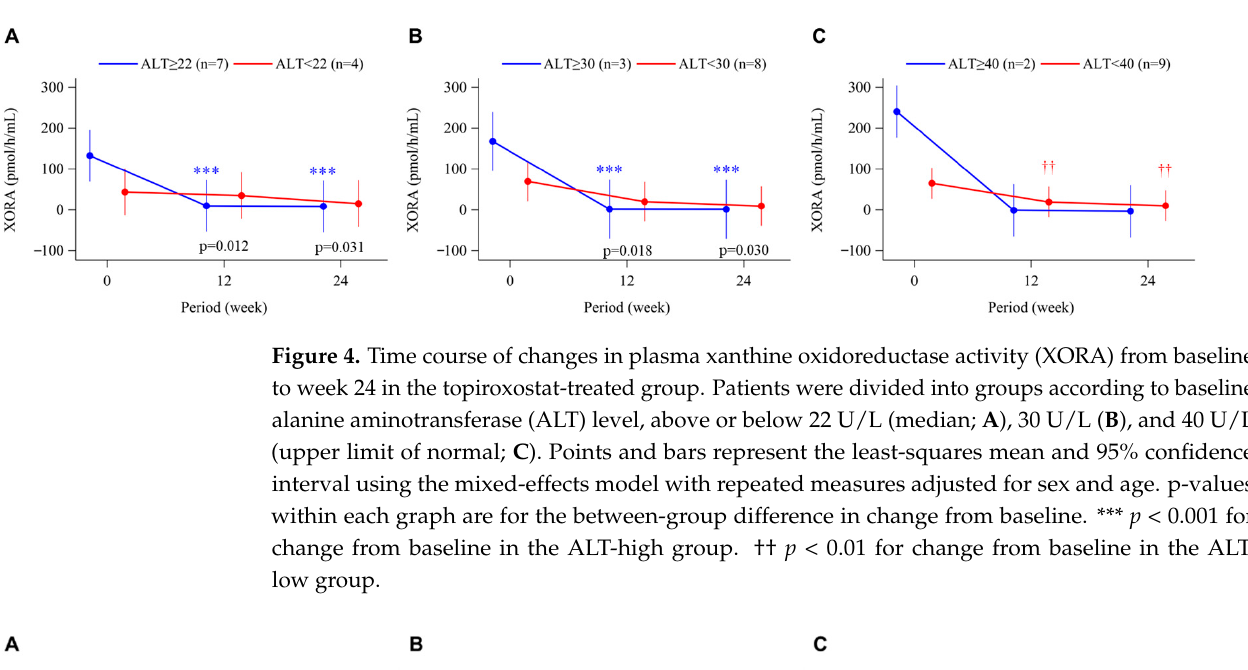
Figure 5. Time course of changes in the urinary albumin-creatinine ratio (UACR) from baseline to week 24 in the topiroxostat-treated group. Patients were divided into groups according to baseline ALT level, above or below 22 U/L (median; A ), 30 U/L ( B ), and 40 U/L (upper limit of normal; C ). Points and bars represent the least-squares mean and 95% confidence interval values using a mixed- effects model with repeated measures adjusted for sex and age. p values within each graph are for the between-group difference in change from baseline. UACR, urinary albumin-creatinine ratio.